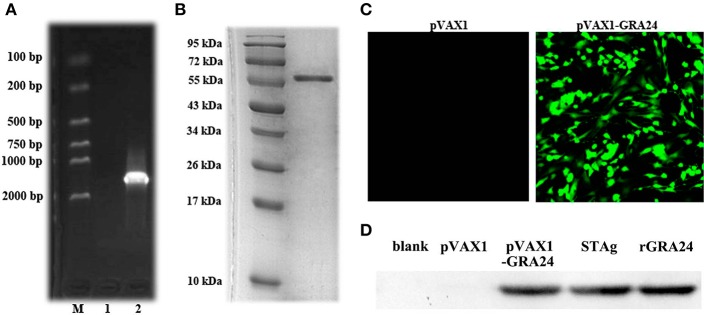
Expression of pET-28a- GRA24 in E. coli BL21(DE3) and pVAX1- GRA24 in HEK293 cell. (A) PCR amplified gra24 gene detected by 1.5% agarose gel. M: Markers; 1: Blank control; 2: coding region (CDS) of T. gondii. (B) Analysis of purified rGRA24 by SDS-PAGE. (C) The expression of pVAX1-GRA24 in HEK293 cells by an indirect immunofluorescence assay. (D) Western blotting detection of the expression of GRA24 in HEK293 cell lysates and STAg. Blank: non-transfected cells; pVAX1: empty pVAX1 transfected cells; pVAX1-GRA24 transfected cells; soluble antigen of T. gondii; rGRA24 acts as a positive control.